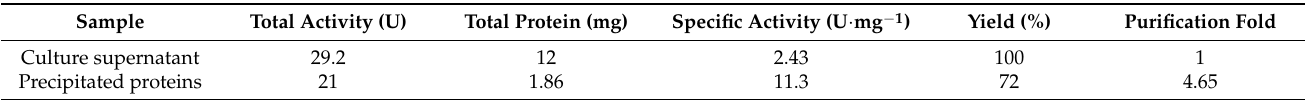
Table 4. Summary of extracellular xylanase precipitation.